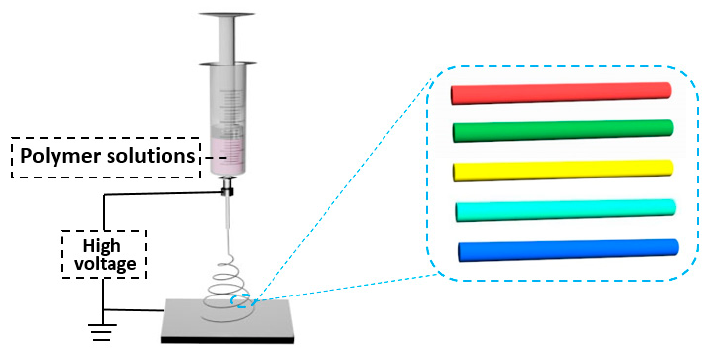
Figure 6. Schematic of electrospinning process for polymer micro/nanofibers.